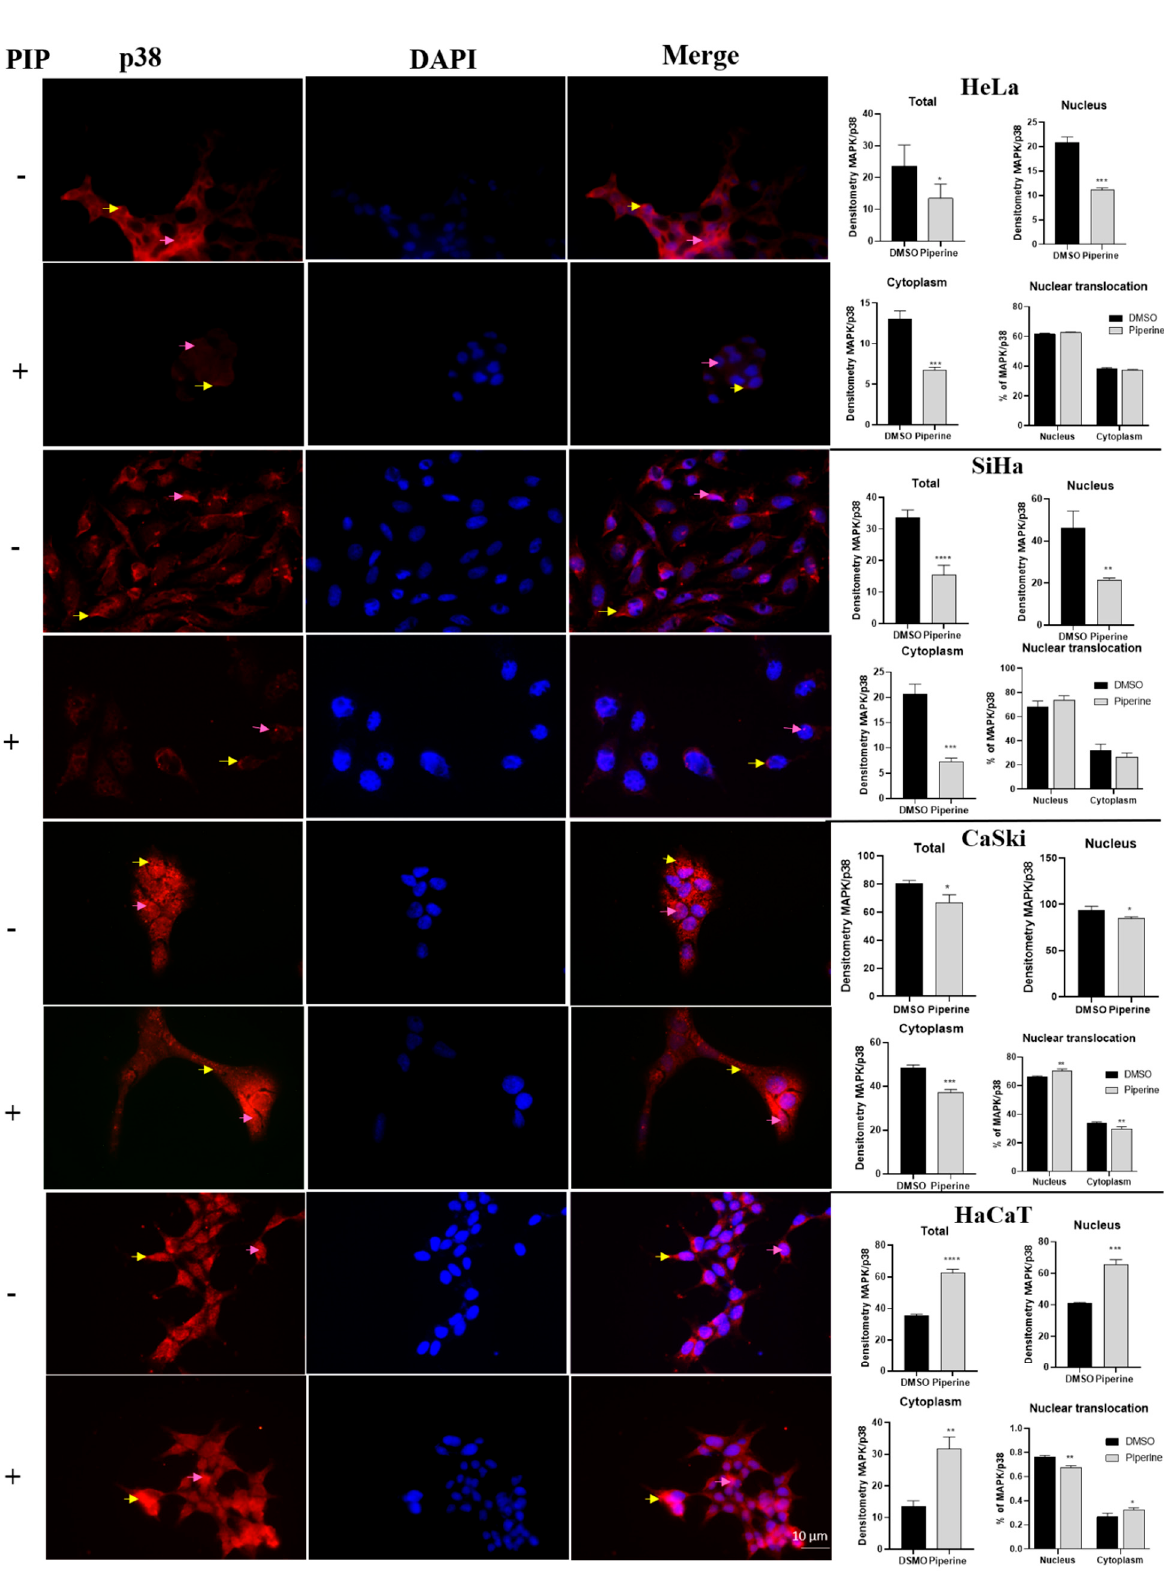
Figure 6. Immunocytochemistry of p38/MAPK protein expression is indicated by a yellow arrow in the cytoplasm and pink in the nucleus. Graphs show the densitometry in each cell and nuclear translocation compartment after treatment with control (DMSO) and piperine [150 µ M]. * vs. control, p < 0.05, ** vs. control, p < 0.01, *** vs. control, p < 0.001, **** vs. control, p <